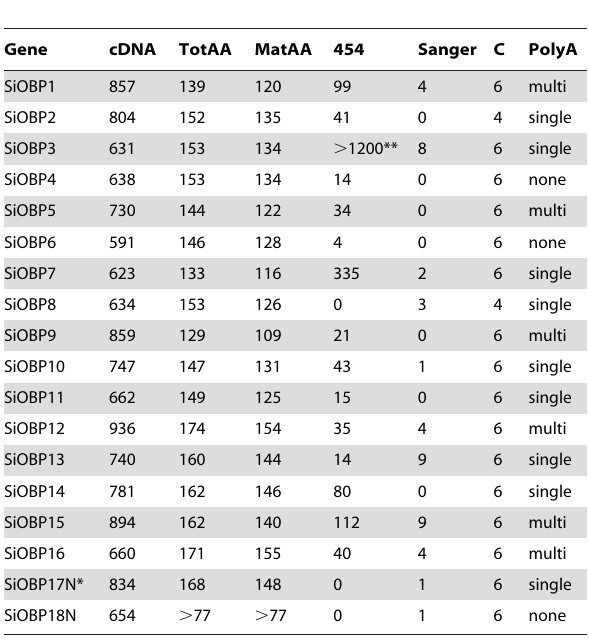
Table 1. Details of the Solenopsis invicta odorant binding